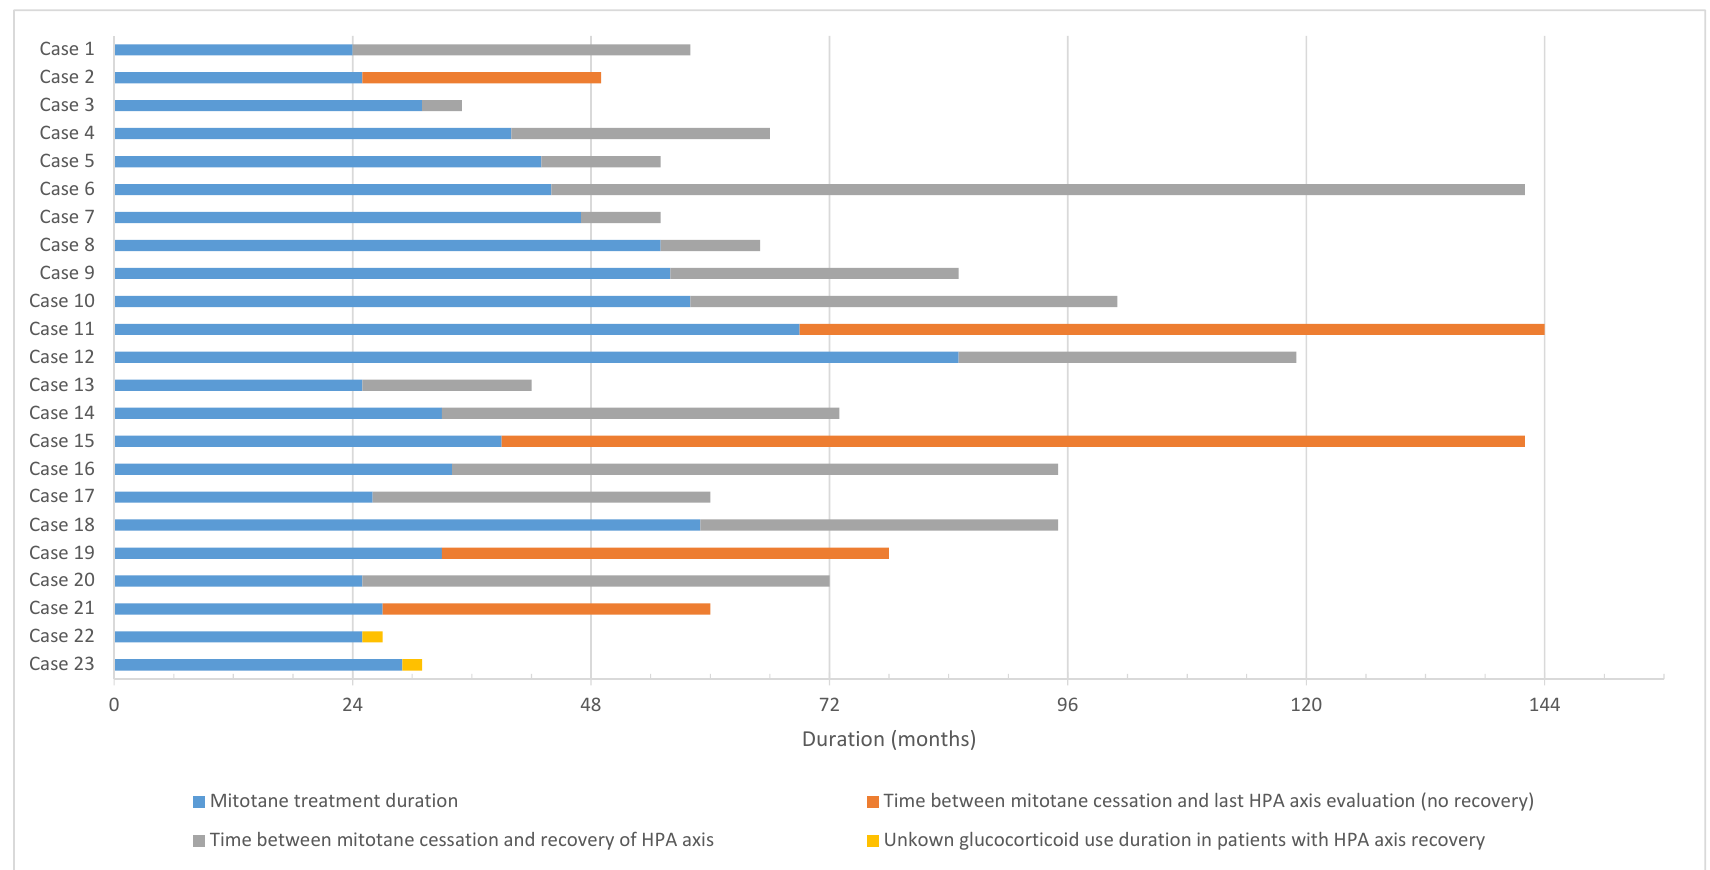
Figure 1. Schematic representation of mitotane exposure and HPA axis recovery timeline for each patient.